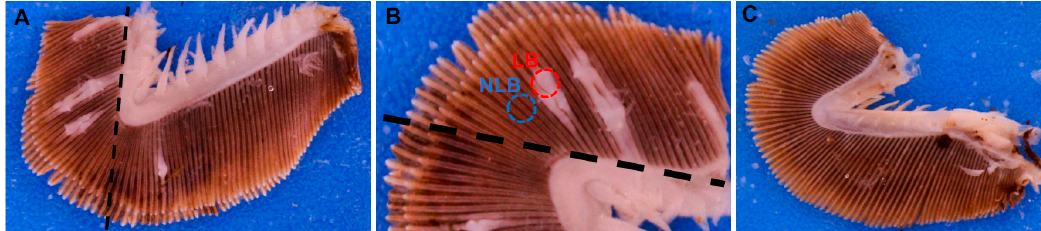
Figure 1. ( A )—Example of AGD affected RH3 hemibranch, and ( B )—subset of ( A ), showing biopsy punch samples obtained from AGD originating gross gill lesions (red) and adjacent unaffected tissue (blue) located in the dorsal region (above dotted black line). ( C )—depicts hemibranch from AGD naïve smolt, with no visible gross pathology.